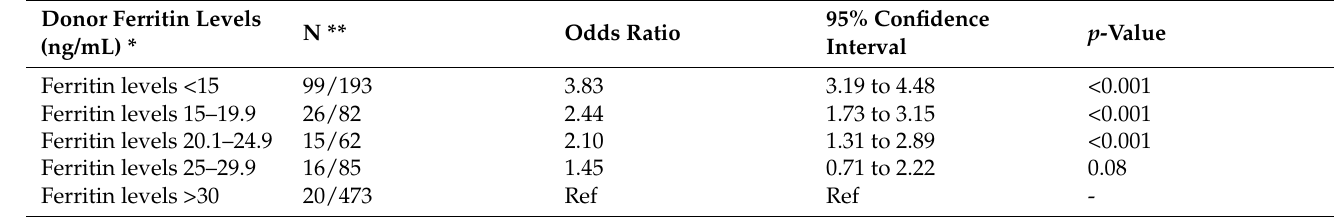
Table 3. Associations between ferritin levels and subsequent low iron levels (ferritin levels <15 ng/mL